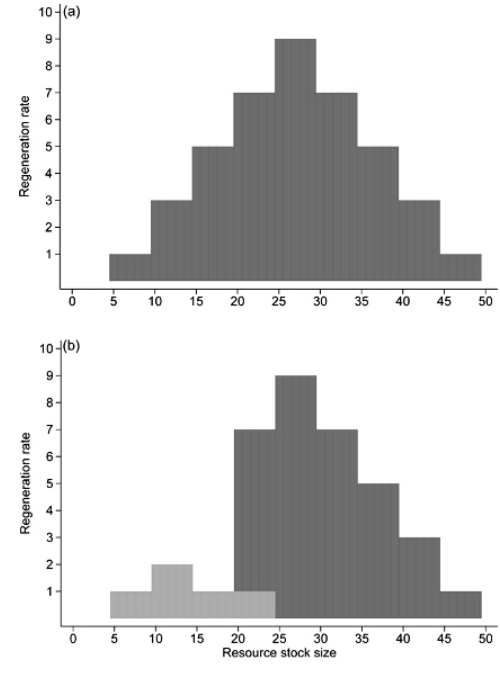
Fig. 1 . Graphical illustrations of the resource dynamics of scenario A (a) and B (b) as presented to the experiment subjects. Graph (a) represents a discrete version of the logistic growth function. Graph (b) shows a resource dynamics that entails a threshold, i.e., there is a drastic and persistent drop in the regeneration rate (at a resource stock size of 20 units). In both scenarios, minimum stock size is set to 5 and maximum to 50 resource stock units. The maximum sustainable yield is set to nine units and the regeneration rate changes by steps of five units. The “hump” between 10 and 15 resource stock size units in scenario B (b) resembles a second steady state of the resource dynamics. Subjects in the threshold treatment were presented with scenario B (b) only; subjects in the risk treatments were presented with both scenarios and a probability of either scenario being